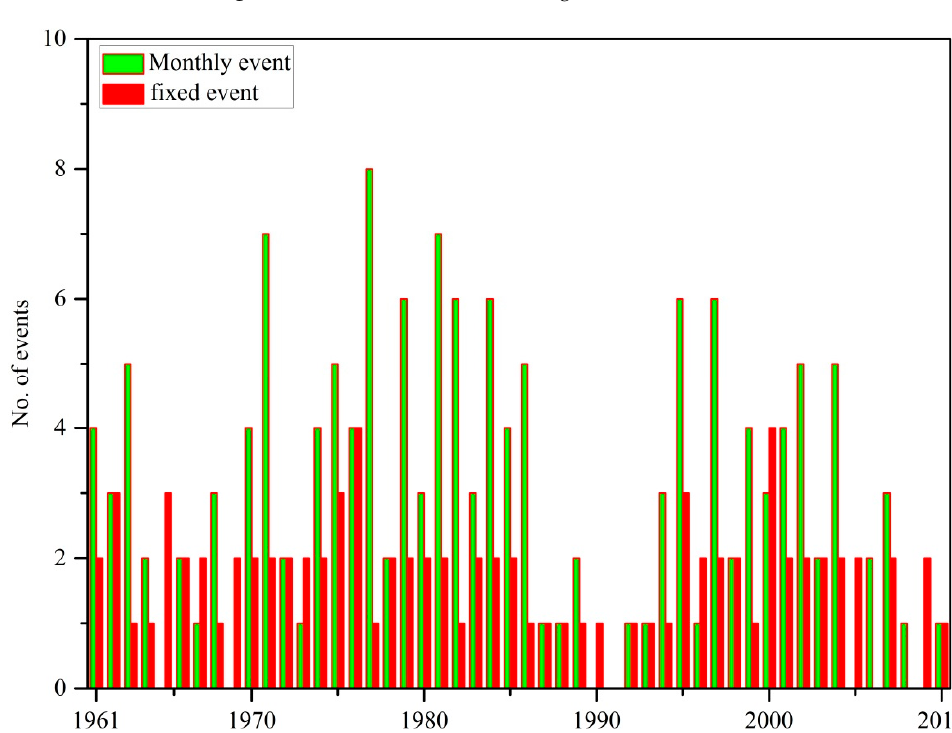
Figure 22. Annual number of drought events in Zone II.